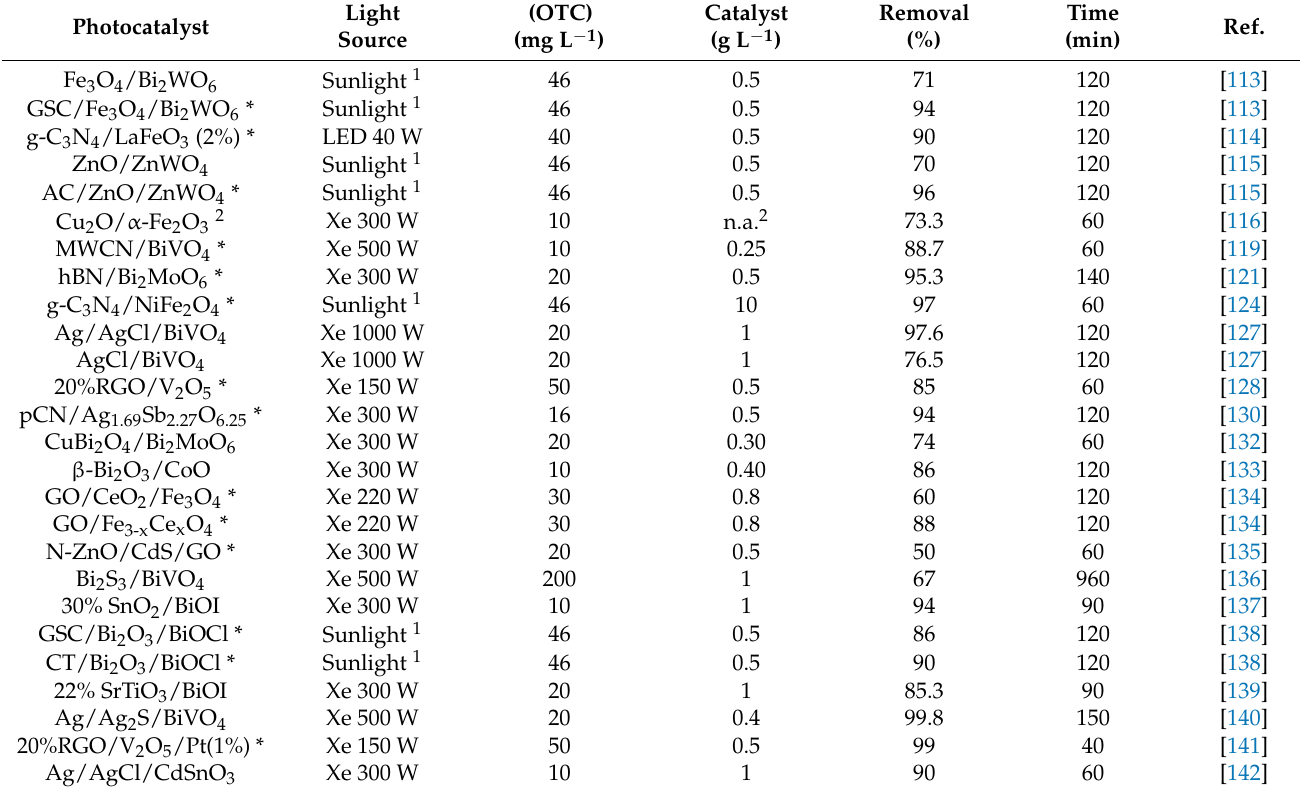
Table 4. OTC photodegradation over semiconductor-oxide-based